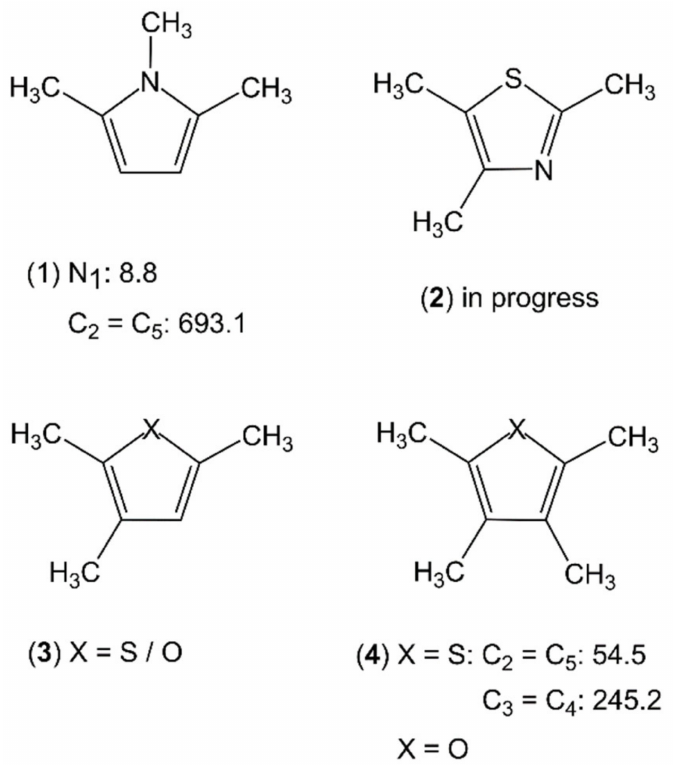
Figure 16. Torsional barriers of the ring methyl rotors in trimethyl- and tetramethyl-substituted planar five-membered rings (in cm − 1 ). ( 1 ) 1,2,5-trimethylpyrrole [27], ( 2 ) 2,4,5-trimethylthiazole, ( 3 ) X = O: 2,3,5-trimethylfuran, X = S: 2,3,5-trimethylthiophene, and ( 4 ) X = O: 2,3,4,5-tetramethylfuran, X = S: 2,3,4,5-tetramethylthiophene